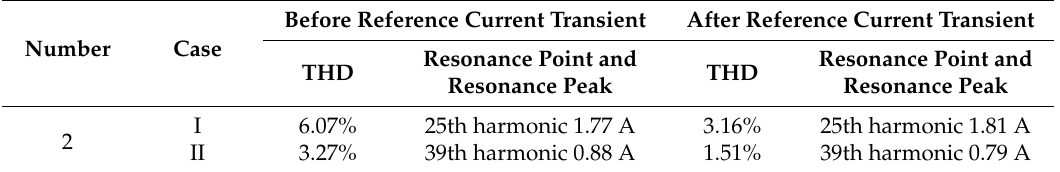
Table 3. Simulation results of grid-connected current with two parallel inverters. THD: total harmonic